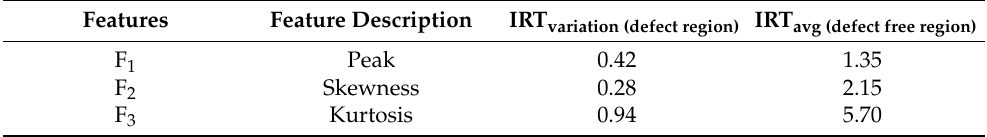
Table 3. Quantitative results of each individual GWT feature.